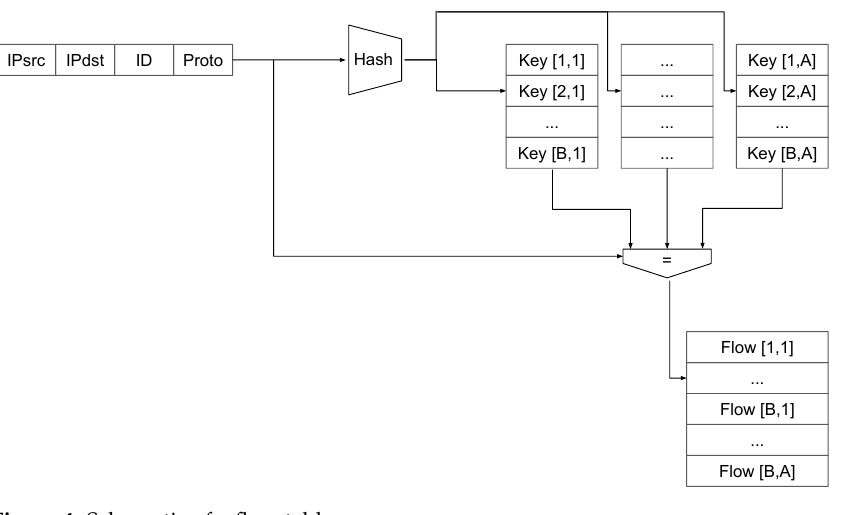
Figure 4. Schematic of a flow